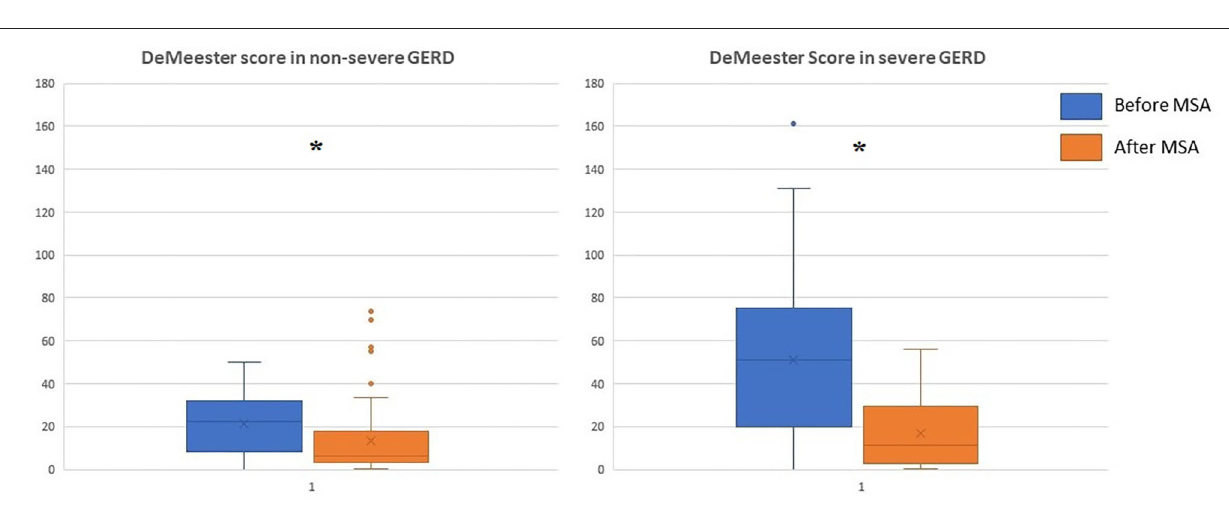
MSA implantation in patients with severe GERD may explain the significantly higher rate of post-operative dysphagia observed in these individuals. In fact, crural repair has an additive effect